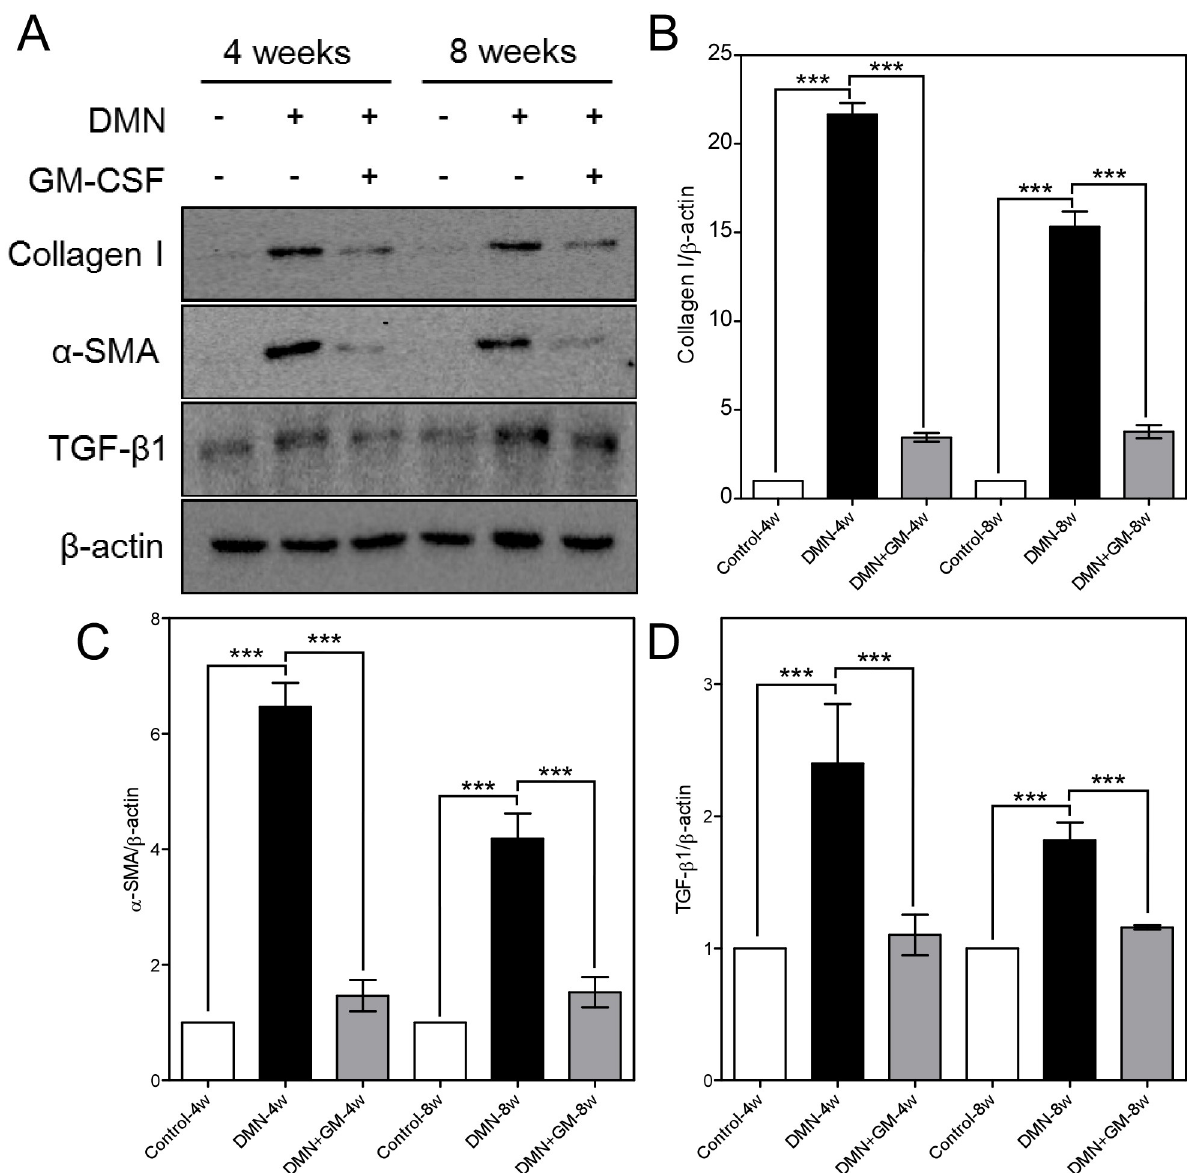
Fig 9. Western blot analysis of collagen type I, α -SMA, and TGF- β 1 in liver. ( A ) Western blot images showing the expressions of collagen type I, α -SMA, and TGF- β 1. β -Actin was used as the internal control. Gray density scanning results of ( B ) collagen type I, ( C ) α -SMA, and ( D ) TGF- β 1 are shown. Results are expressed as means ( ± SEMs). Significant differences were observed between the control and DMN groups and between the DMN groups and the DMN+GM-CSF groups ( ��� p � 0.001).